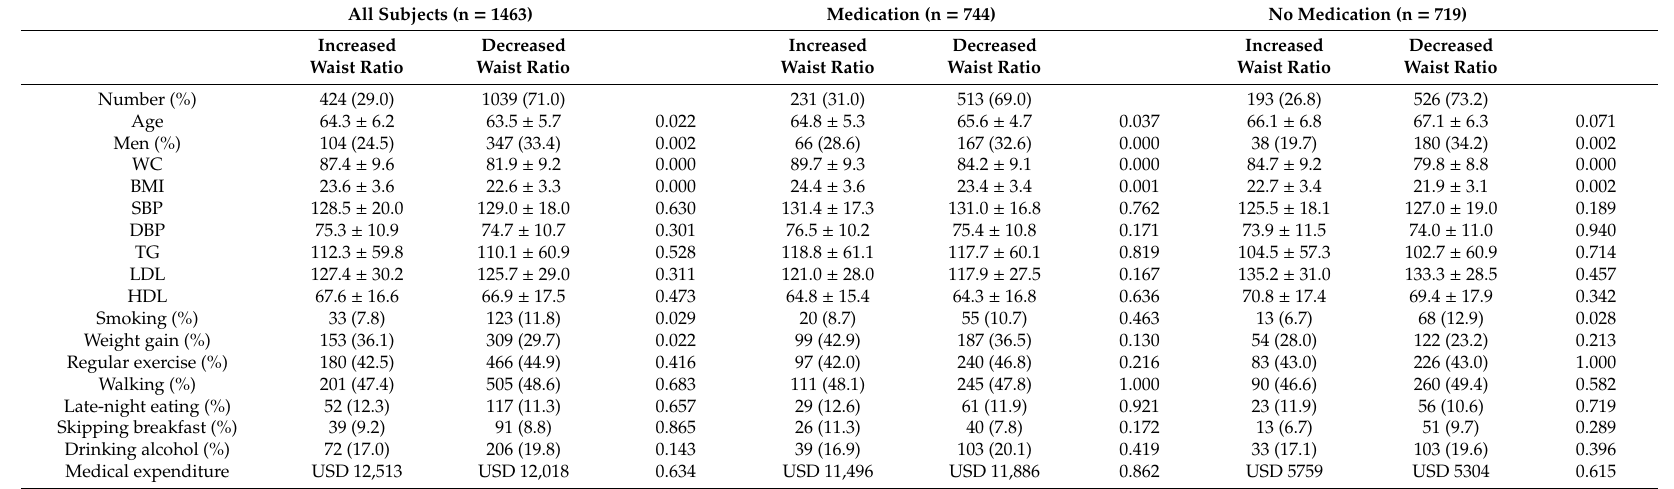
Table 1. Characteristics of the subjects by medication status at the end of the follow-up